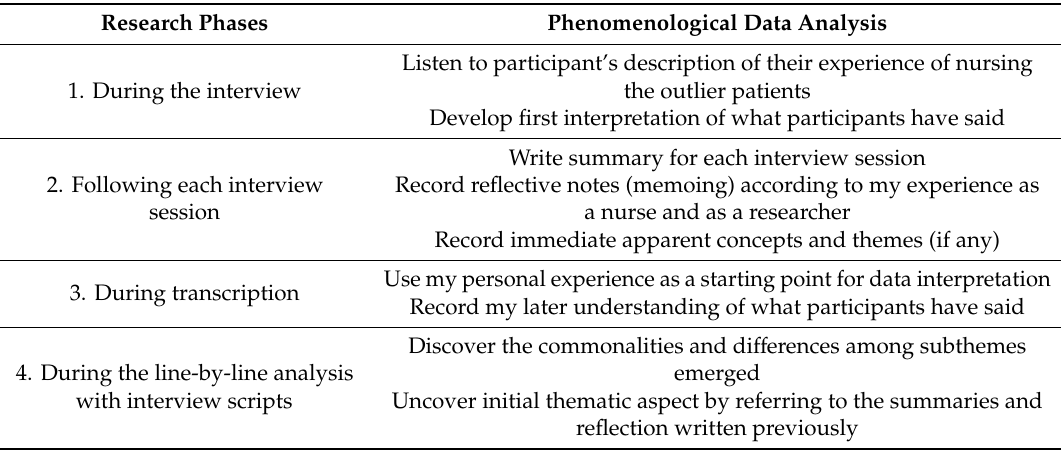
Table 2. The non-linear process of phenomenological data analysis applied in this study.